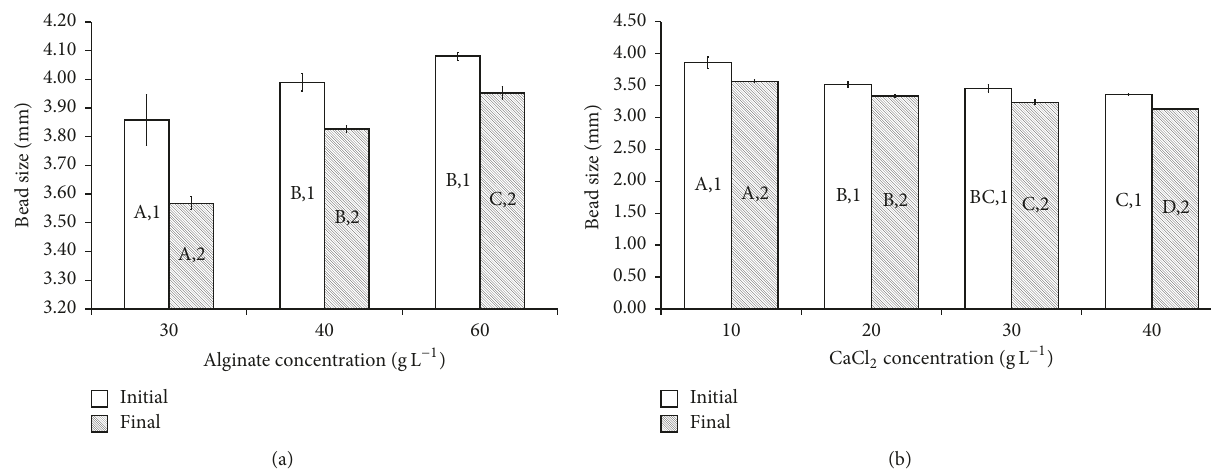
Figure 2: The diameter (mm) of alginate bead during initial and final incubation periods. The different letter at each initial and final period indicated significant difference ( 𝑝 value ≤ 0.05) between alginate beads prepared by using different (a) alginate concentrations and (b) hardening by different concentrations of CaCl 2 solution. The different number at each treatment indicated that initial size of alginate bead is significantly different ( 𝑝 value ≤ 0.05) from final size of bead.